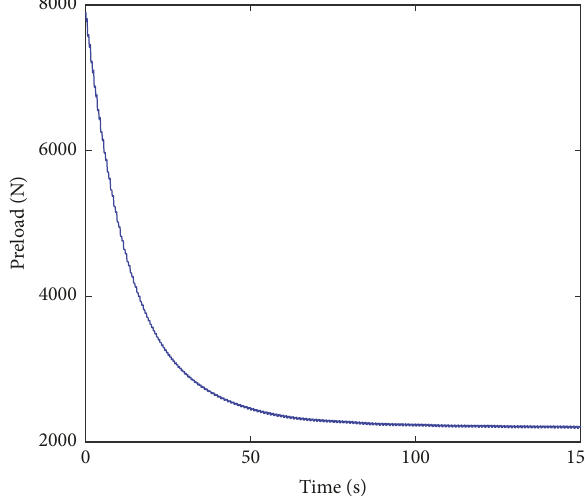
Figure 17: The curve of preload variation during the 150